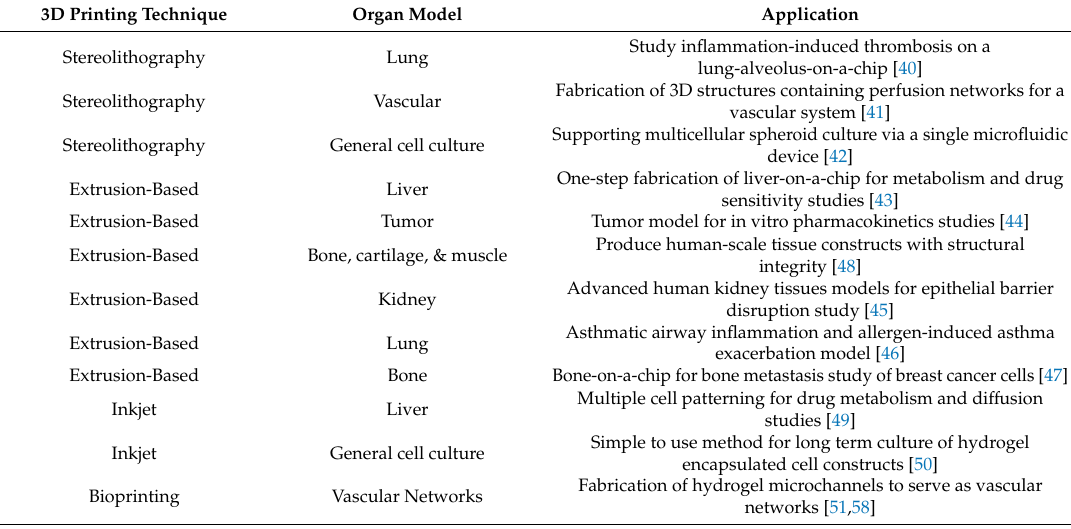
Table 2. A list of potential organ models and their applications fabricated from various 3D printing